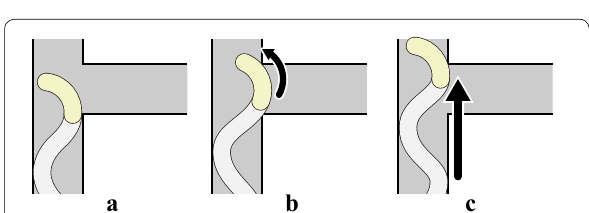
Fig. 9 Strategy for bypassing Type B branch. a Device approaches a branch, keeping the hook facing away from the branch. b Because the hook faces a wall that is opposite to the branch, the hook does not catch the branch. c Device does not